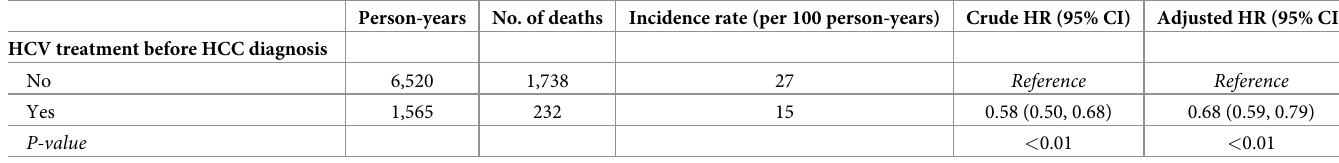
Table 2. Hazard ratios (95% confidence intervals) for all-cause mortality of patients with hepatitis C virus-related hepatocellular carcinoma according to prior hep- atitis C virus treatment. Person-years No. of